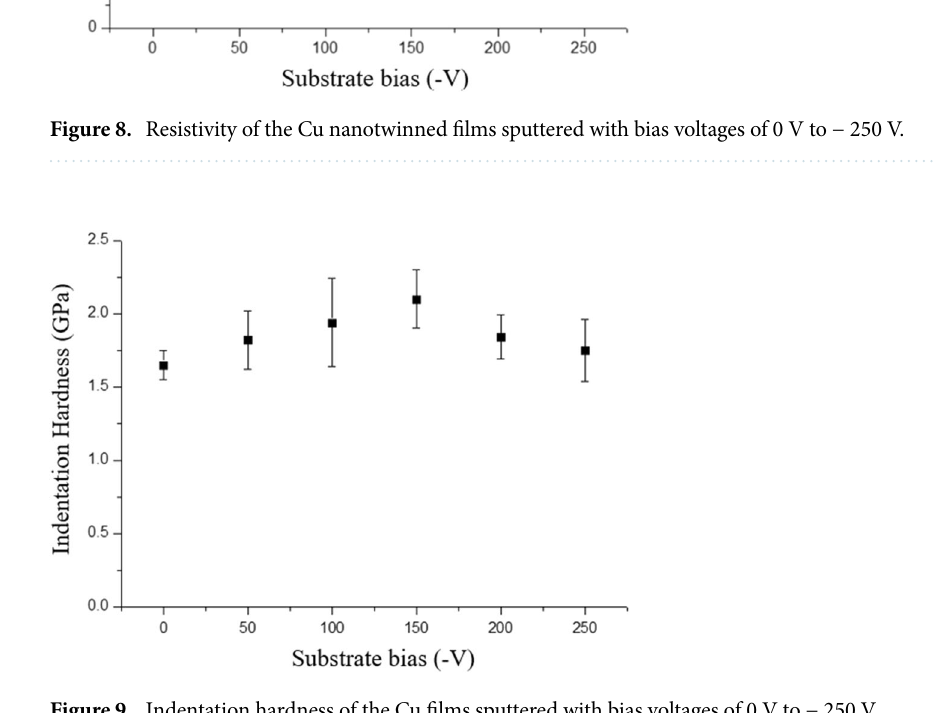
Figure 9. Indentation hardness of the Cu films sputtered with bias voltages of 0 V to − 250